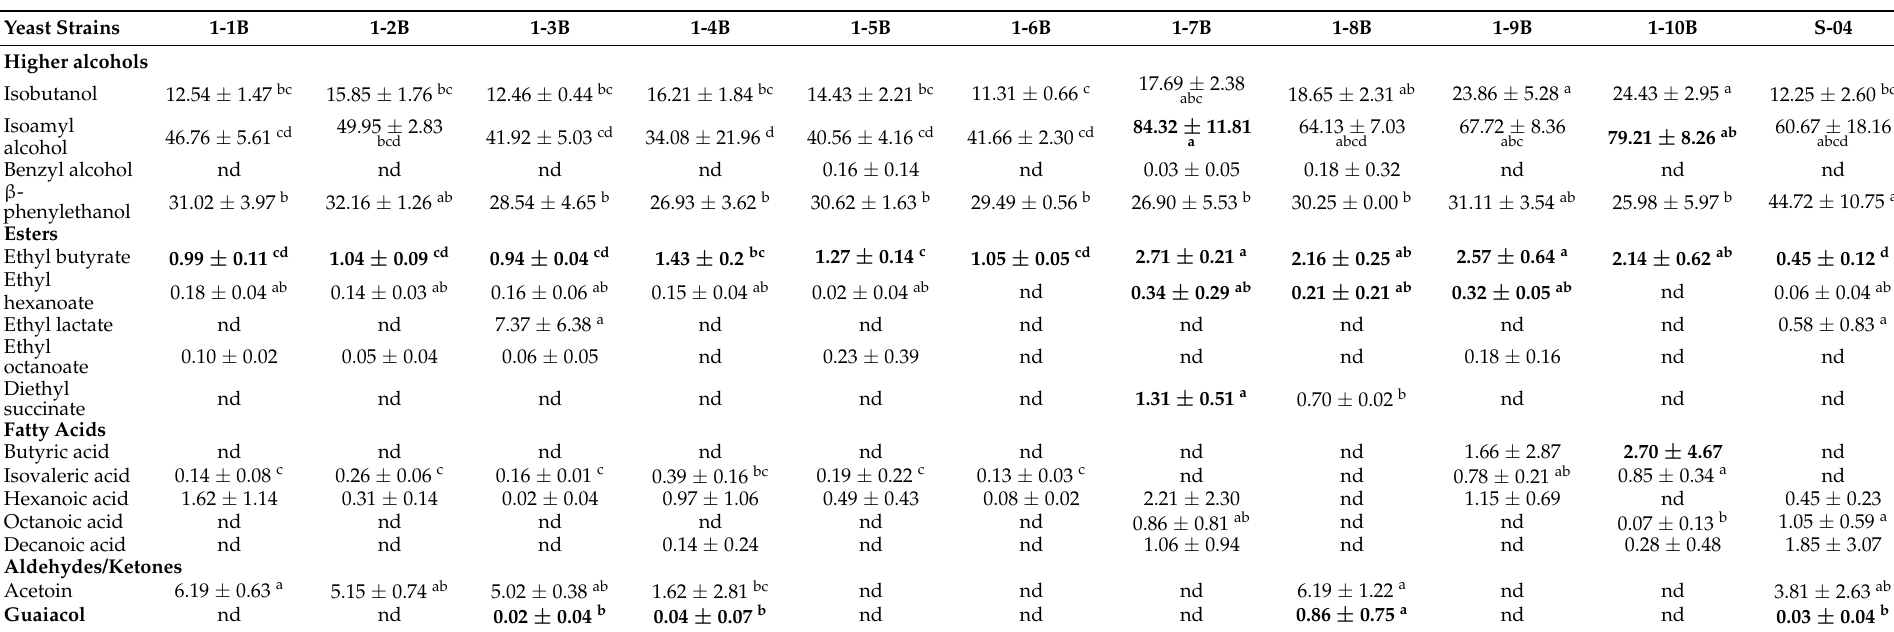
Table 2. Main volatile compounds found in the beers obtained with the 10 yeast strains of L. thermotolerans and strain S-04 in 100